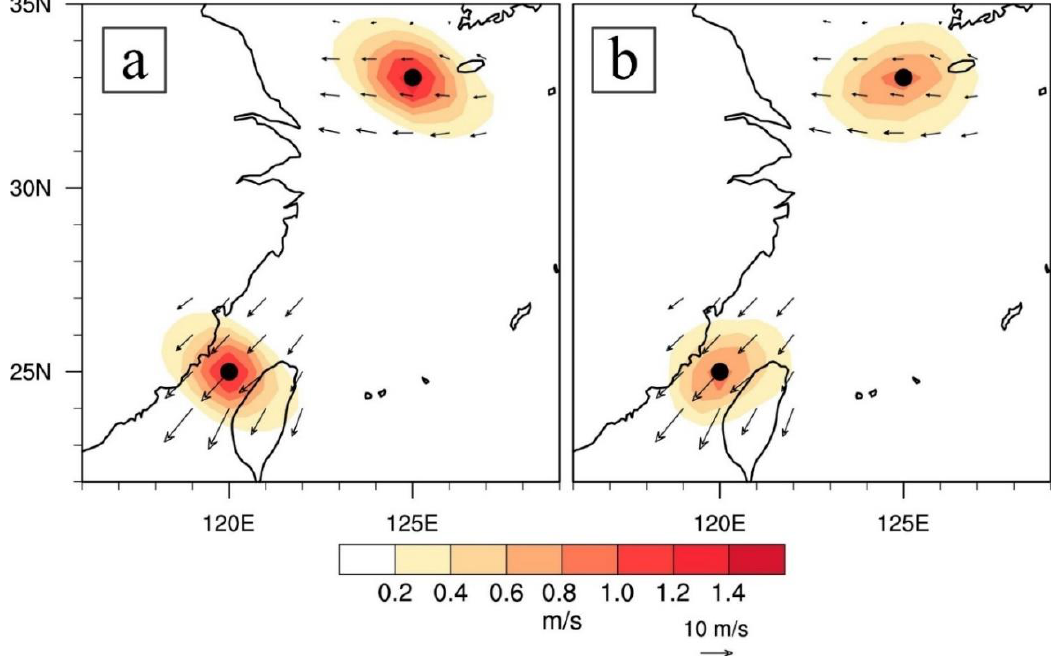
Figure 15. Comparison between ( a ) 3DVAR and ( b ) EnKF for u wind component (colors) increments at 1000 hPa in single synthetic observation tests from Exp-AS1 to Exp-AS4. Vectors show background flow.